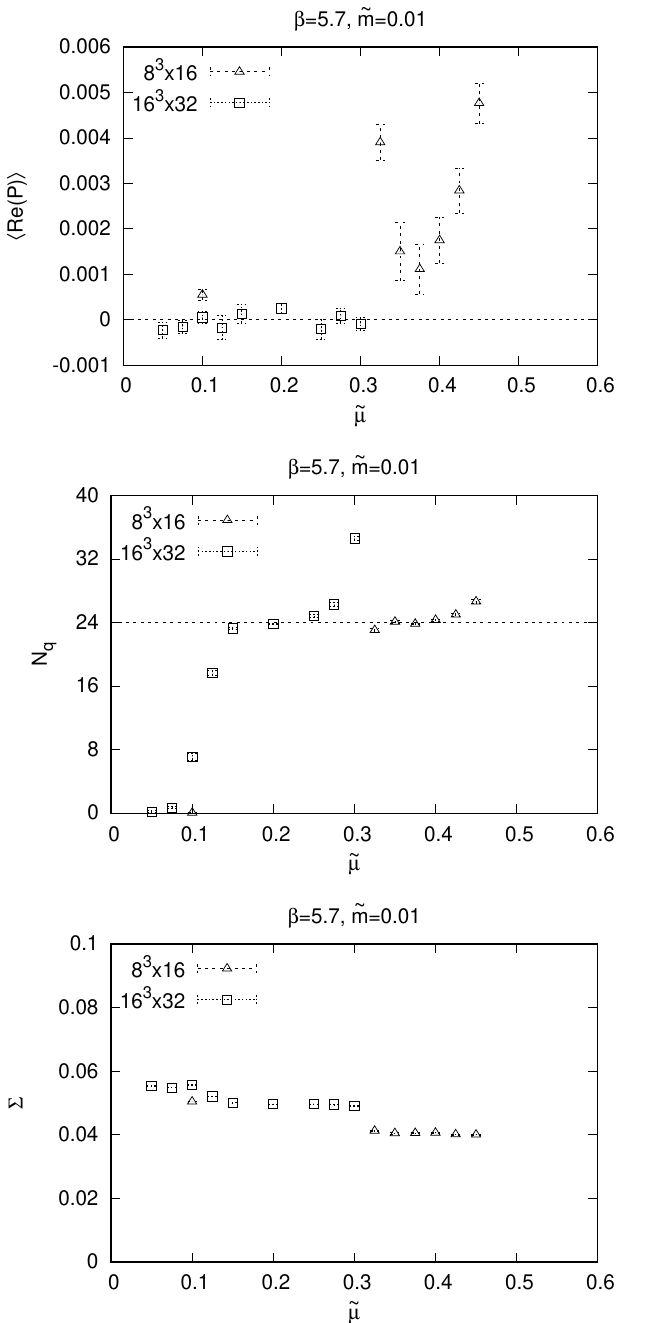
Figure 4 . The real part of the Polyakov loop P (Top), the quark number N q (Middle) and the chiral condensate (cid:6) (Bottom) are plotted against the quark chemical potential ~ (cid:22) for (cid:12) = 5 : 7 and ~ m = 0 : 01 on the 8 3 (cid:2) 16 and 16 3 (cid:2) 32 lattices.